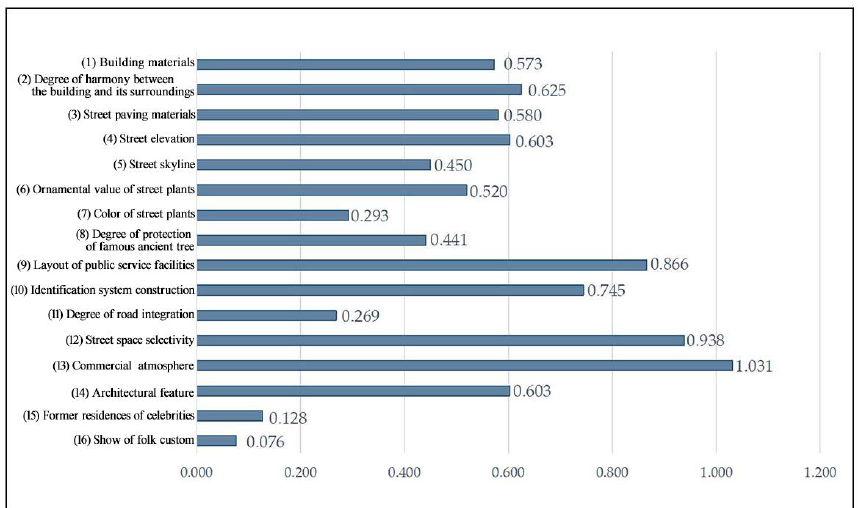
Figure 3. Evaluation values of landscape preference indicators for the “Cross-shaped” spatial sample.